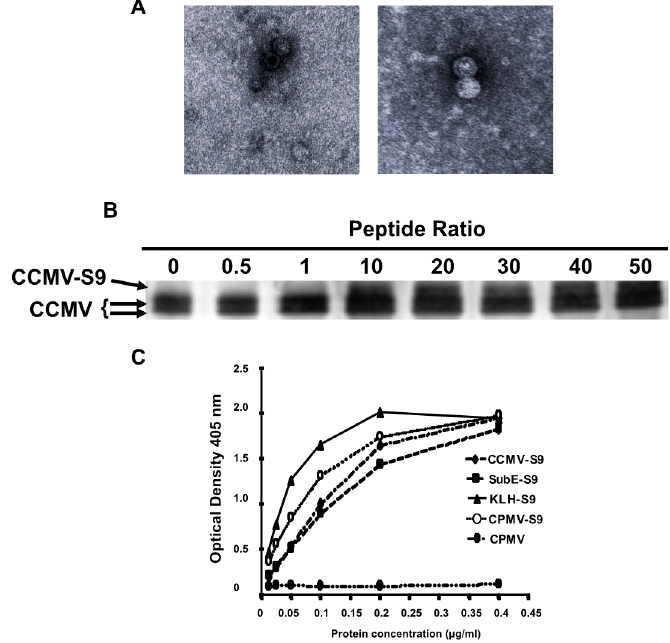
Figure 1. Production of VLPs and chemically conjugated VLPs. ( A ) Transmission electron micrographs of VLPs purified on a density gradient; ( B ) Coupling of S9 peptide to VLPs. VLPs of ssCCMV were incubated with cross ‐ linking reagent at a 1:1 ratio of cross linker to capsid subunit. Different concentrations of the peptide were then added. After 1.5 hours, the reaction was stopped and samples loaded onto non ‐ reducing 12% SDS ‐ PAGE gels and visualized by silver stain. Free and peptide ‐ conjugated capsid protein was observed; ( C ) Measurement of S9 ‐ peptide on different immunogens. The protein concentration of the different immunogens was determined by the BCA method. Different concentrations were coated onto ELISA wells. Peptide was detected with the S9 mAb, then alkaline phosphatase ‐ conjugated anti ‐ mouse IgM.